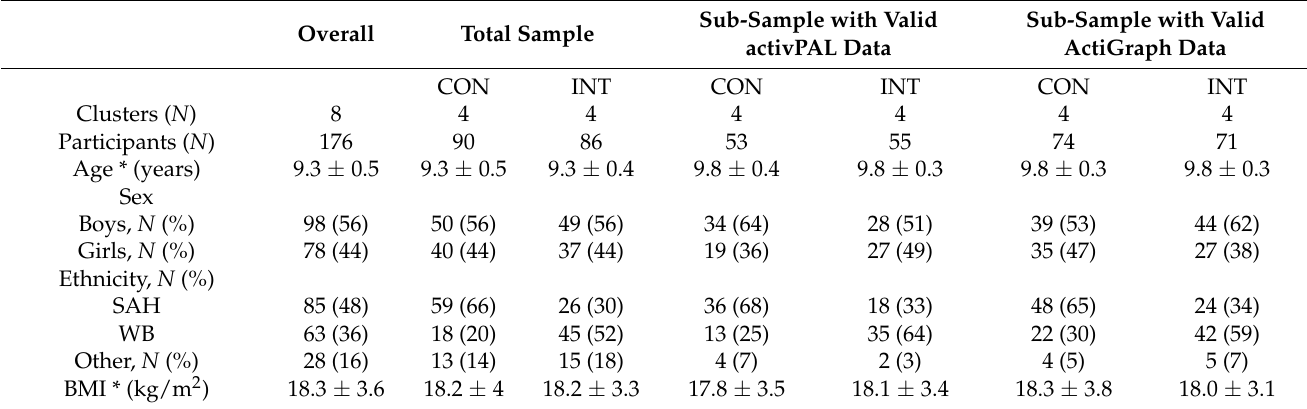
Table 1. Descriptive characteristics of the overall sample and the sub-samples who provided valid activPAL and ActiGraph data at both baseline and follow-up assessment sessions. Sub-Sample with Valid Sub-Sample with Valid Overall Total Sample activPAL Data ActiGraph